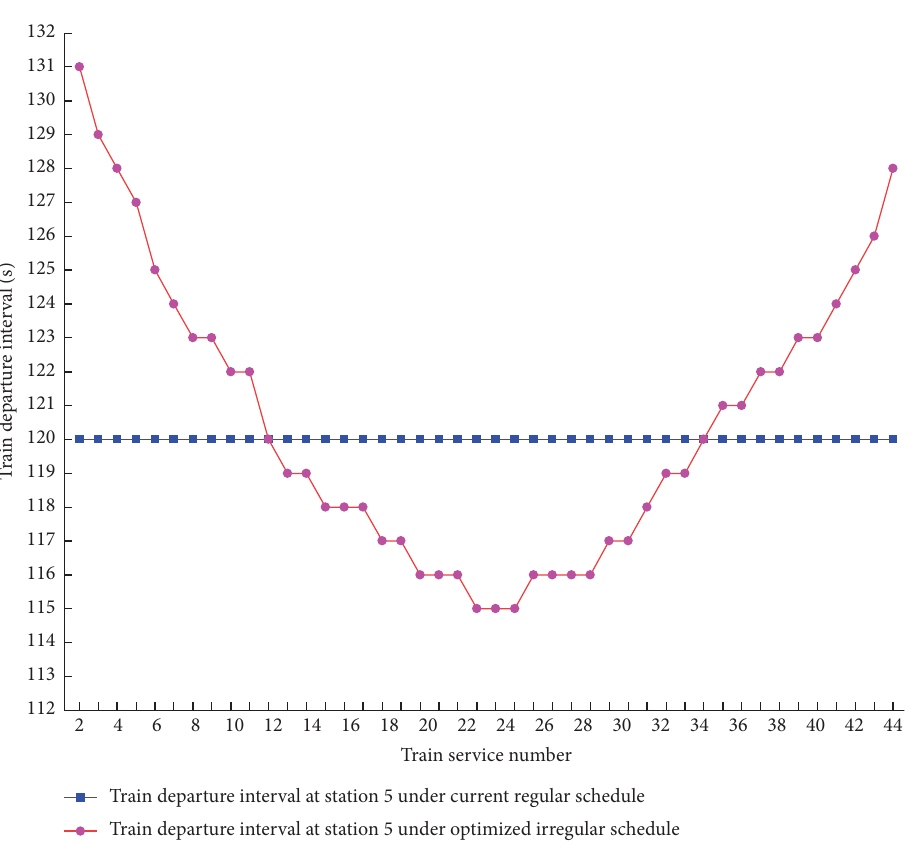
Figure 6: Train departure intervals under the optimized irregular schedule and current regular